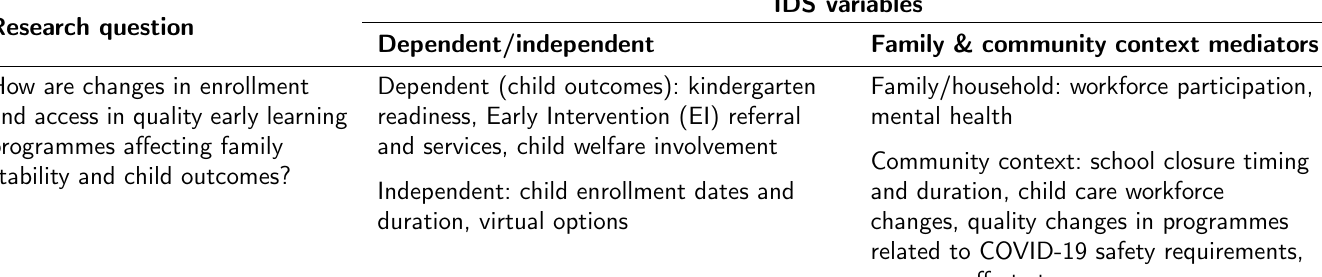
Table 2: Possible research questions and ids variables for impact research about young